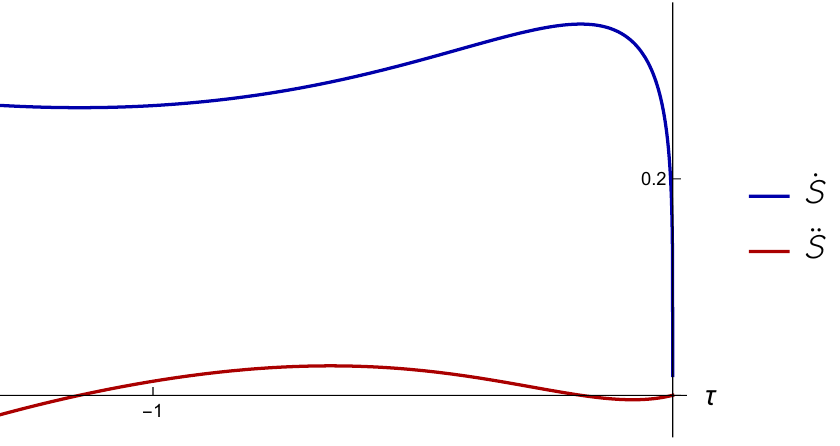
˙ ¨ S ( T ) , S ( T ) as a function of τ , for c B = − 1 , r = − 0 . 26 . In the τ → 0 limit, we